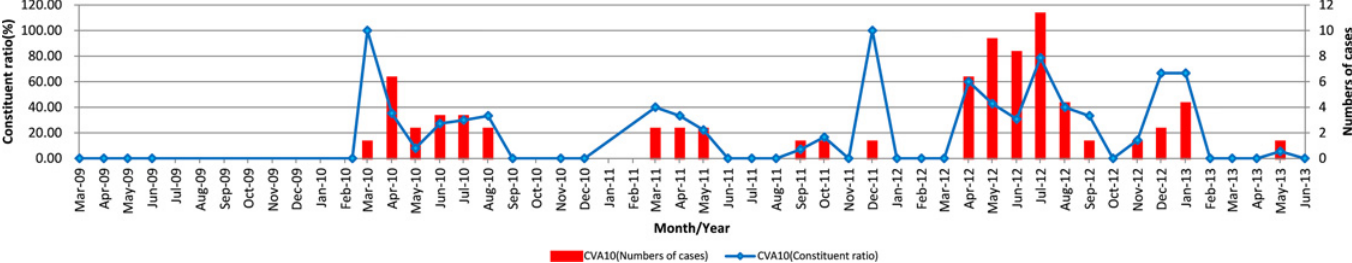
Fig 4. Monthly distribution of CVA10 associated with HFMD during 2009 to June 2013 in Jinan, China.